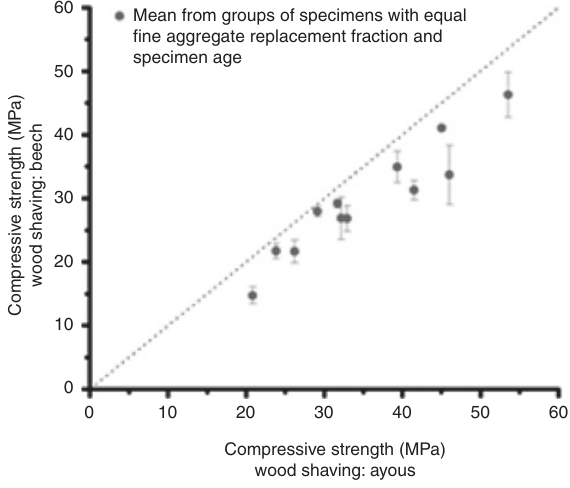
Figure 6: Comparison of compressive strength test results from groups of six specimens with specified fine aggregates fraction and specimen age (each group corresponding to one figure point).